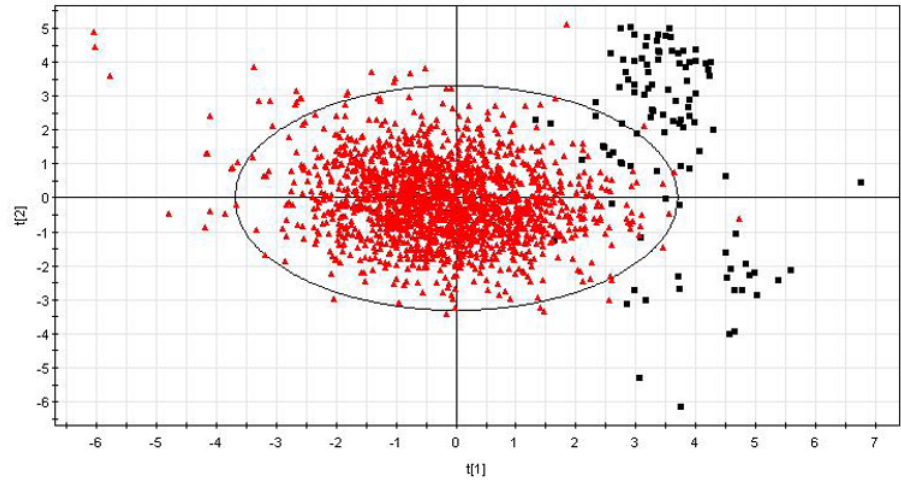
Figure 3. PLS-DA score plots, for the first two latent variables - actives (black squares) and inactives (red